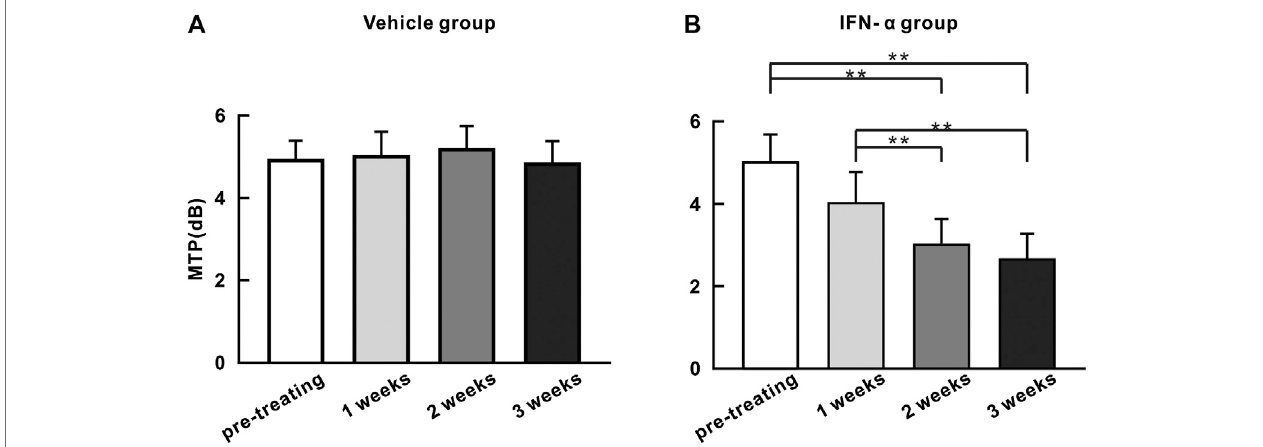
FIGURE 4 | ASSR strength (MTP) does not signi fi cantly change with time in the saline injection group (A) but decreases with time in the IFN- α group (B) . Bars represent the mean of MTP ( n (cid:1) 10). Error bar represents SE. ** indicates p < 0.01, ANOVA, and Tukey ’ s post hoc test.